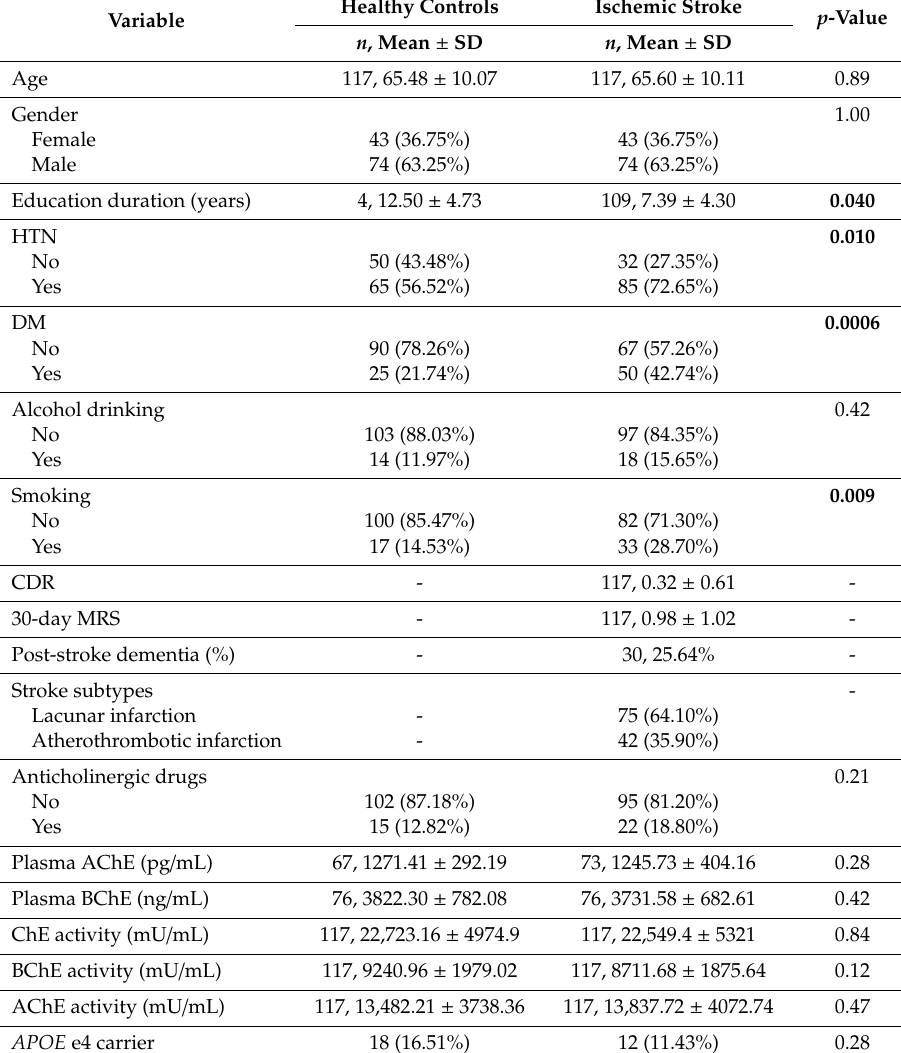
Table 1. The association analyses between ischemic stroke patients and healthy